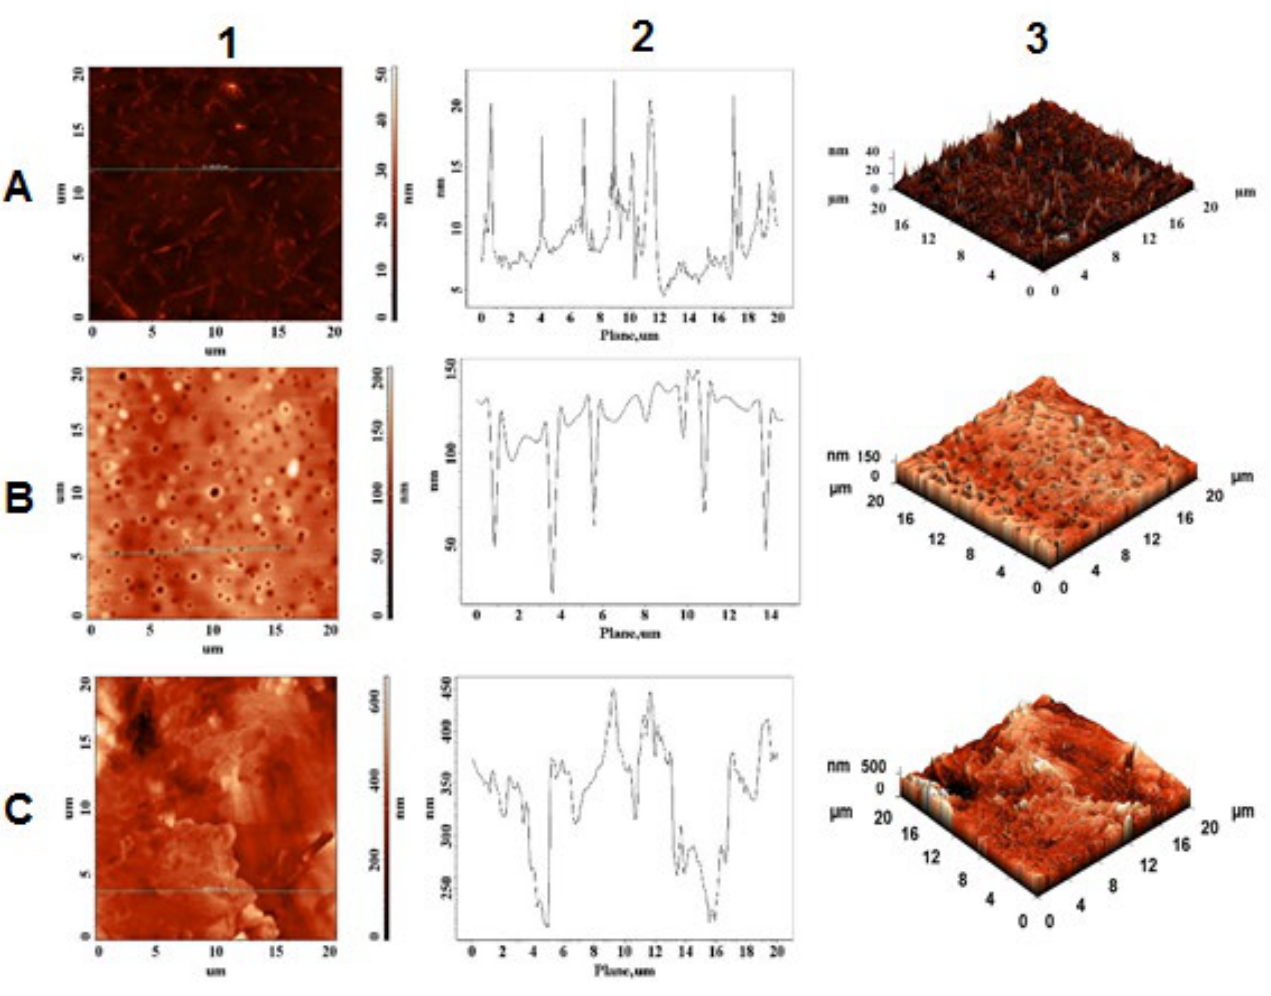
Figure 9. AFM images of NAP peptide ( A ); in the presence of copper ions ( B ) and zinc ions ( C ); (1) height of AFM images; (2) plot height distribution of particles along the profile line; and (3) 3D AFM images.